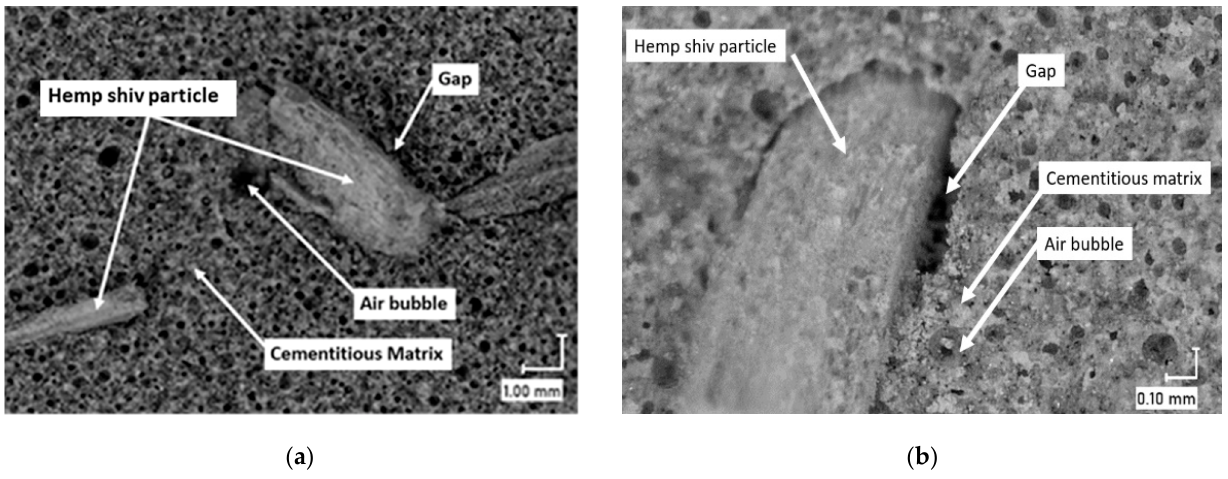
Figure 4. ( a ) Overview of the pore structure of the BFC material. ( b ) Interface between the cementi- tious matrix and the hemp shiv .